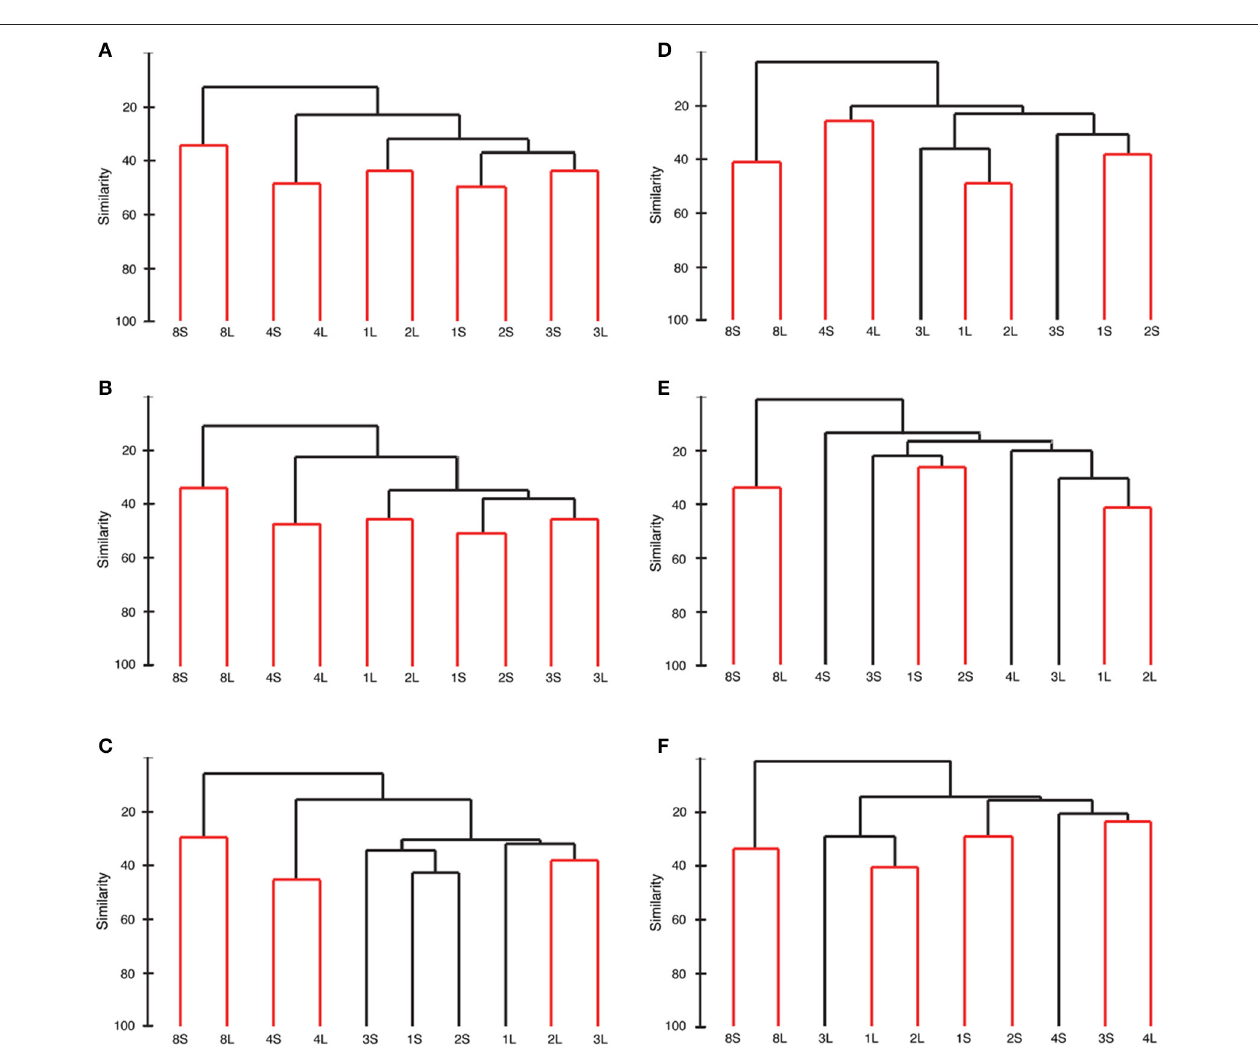
FIGURE 6 | Sample relatedness of bacterial (A–C) and archaeal samples (D–F) when OTUs are picked at a 97% (A,D) 99% (B,E) , and 100% (C,F) level. Black bars represent statistical significance, numbers represent the station, S denotes small particles between 0.45 and 0.8 µ m and L denotes large particles > 8.0 µ